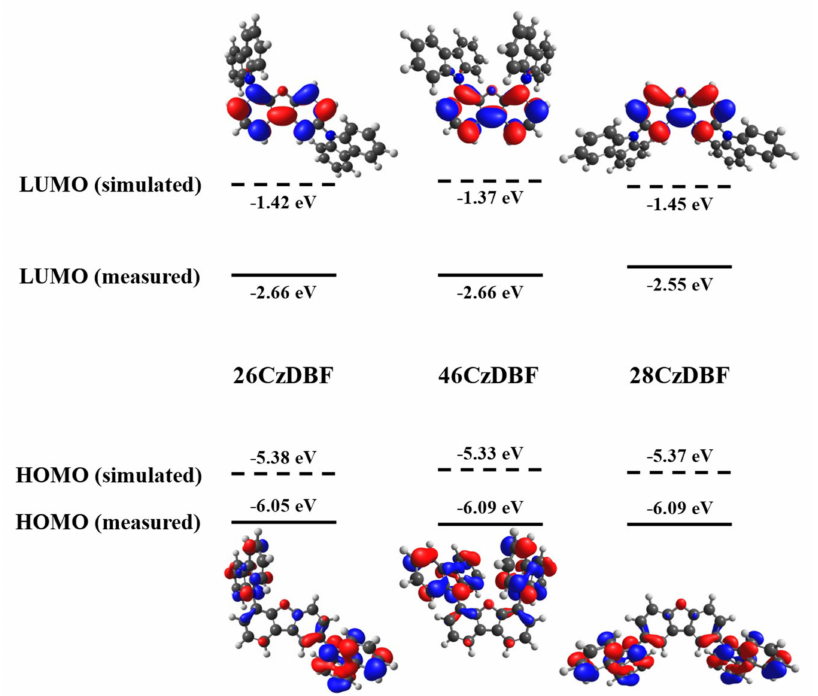
Figure 1. The HOMO and LUMO calculated and experimental results of 26CzDBF, 46CzDBF, and 28CzDBF.